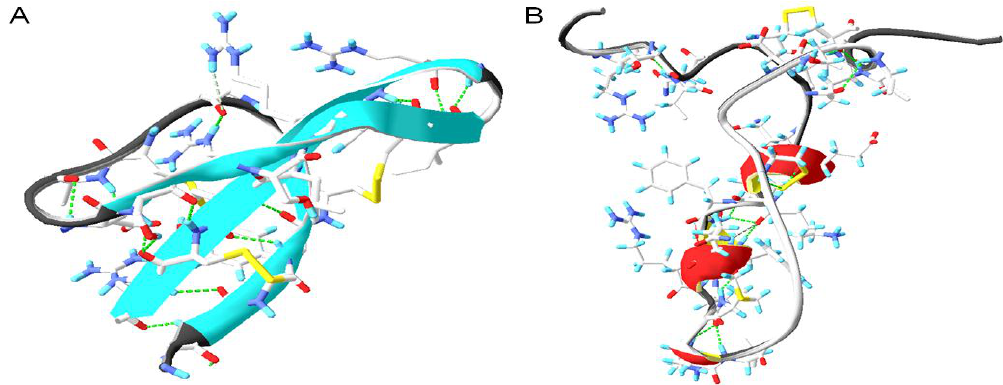
Figure 5. Salt bridges in antimicrobial peptides. The overall secondary structure is depicted, in addition to side-chains and back-bone elements that are involved in stabilizing the structure; hydroben bonding (green dotted lines) or salt bridges (grey dotted lines). The PDB codes are all indicated, in addition to the primary sequence with the disulfide bridges indicated with numbers in subscript. ( A ) On human defensin 5 (PDB code 2LXZ) ATC 1 YC 2 RTGRC 3 ATRESLSGVC 2 EISGRLYRLC 3 C 1 R [115], it is apparent how Arg 6 and Arg 28 from β-strand 1 and 3, clam around and stabilize the random coil backbone through formation of one hydrogen bond and one salt bridge; ( B ) Human lactoferricin 1-49 (PDB code 1Z6V) GRRRRSVQWC 1 AVSQPEATKC 2 FQWQRNMRKVRGPPVSC 2